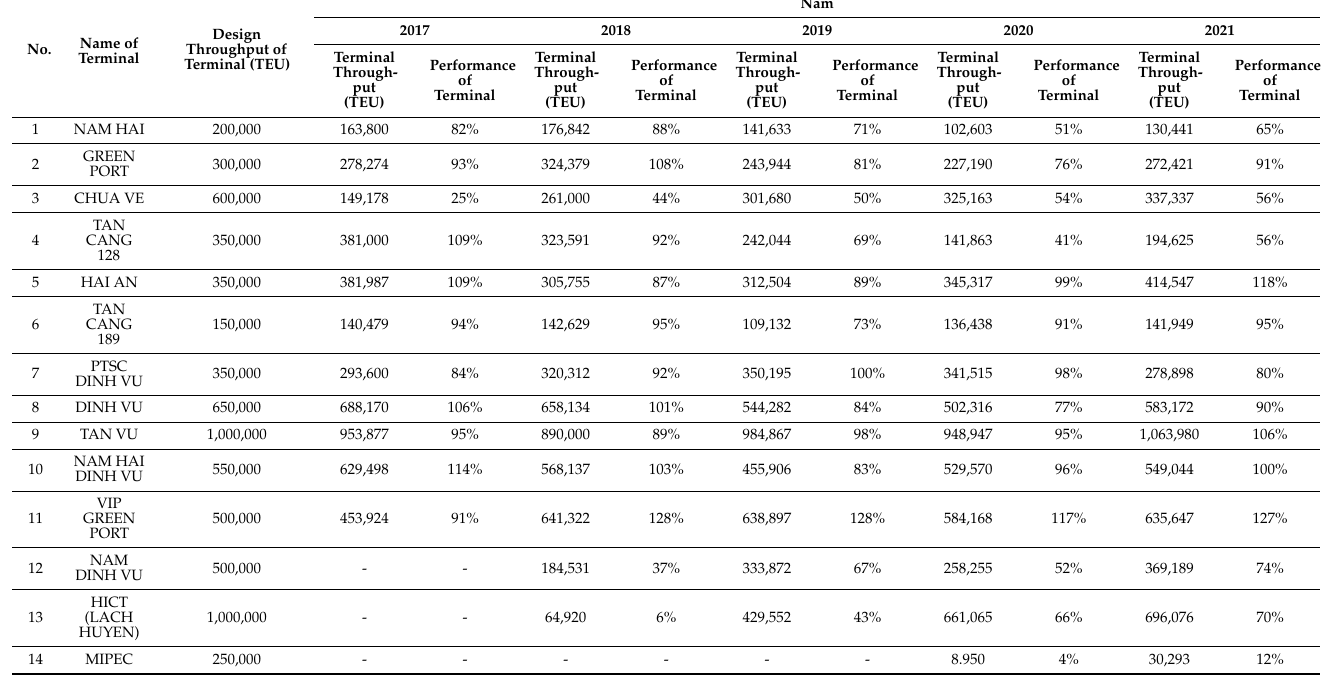
Table 8. Performance of container terminals in the Hai Phong